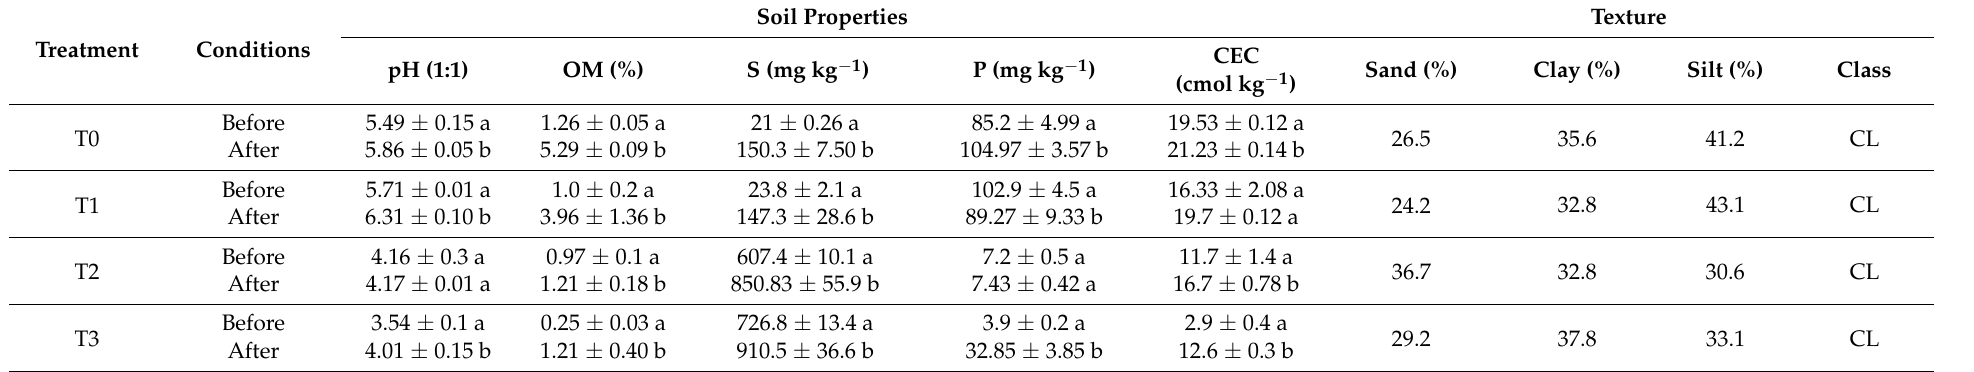
Table 1. Physicochemical parameters of soils before and after the phytoremediation process.